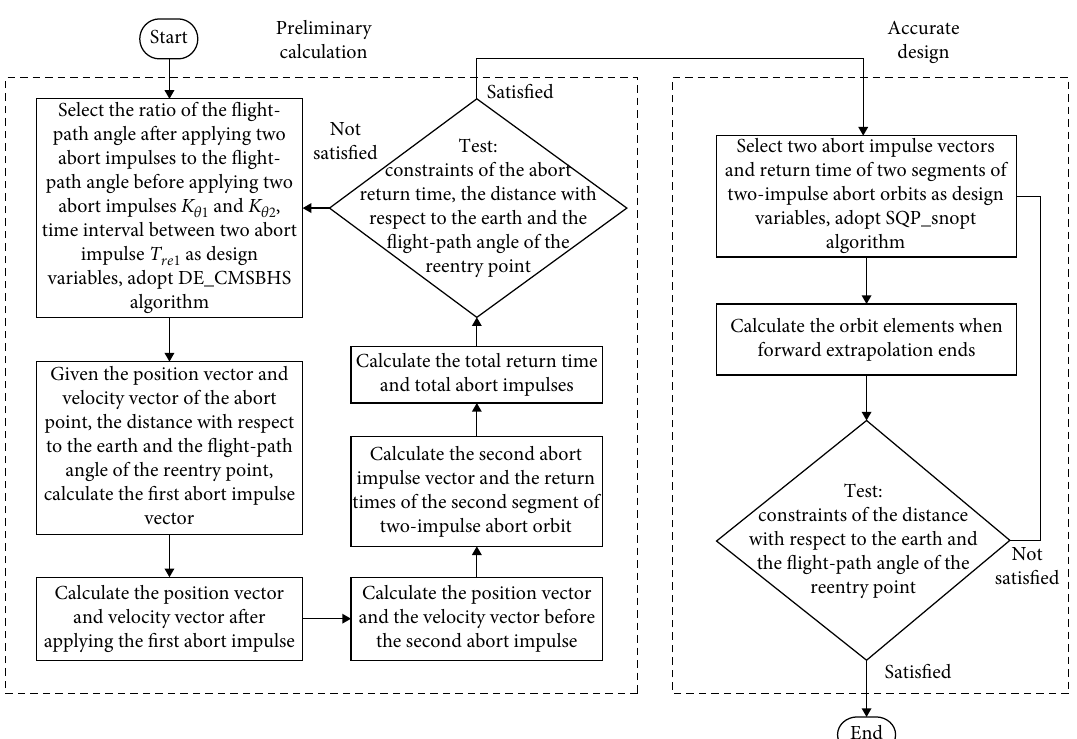
Figure 3: Flow chart of the two-impulse abort orbit design